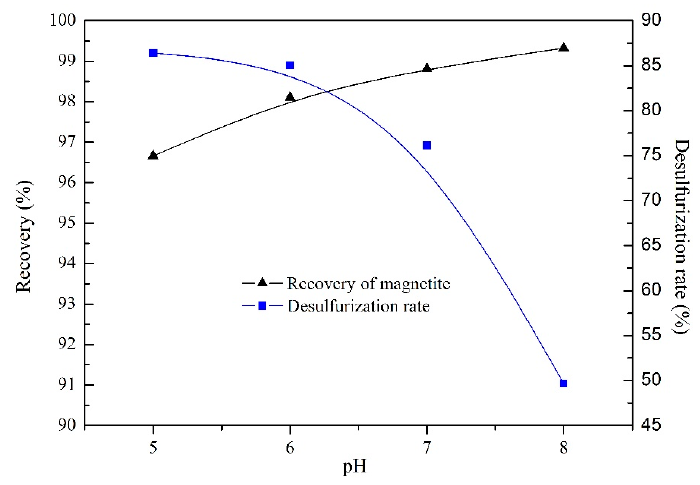
Figure 6. The magnetite recovery and desulfurization ratio in flotation concentrate as a function of pH with mixed collector (NaBX 75 g/t, (BX) 2 50 g/t, NaSiF 6 500 g/t, pine oil 46 g/t).